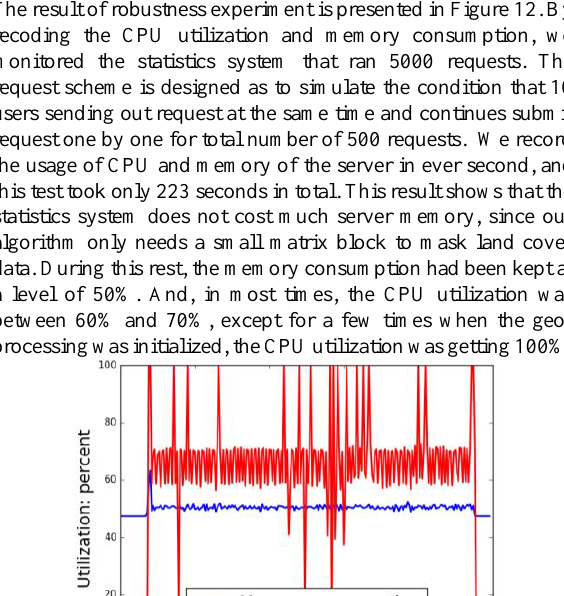
Figure 11 . Result of concurrency test. The blue line denote the maximum response time of GSA and the red line denotes the average response time.